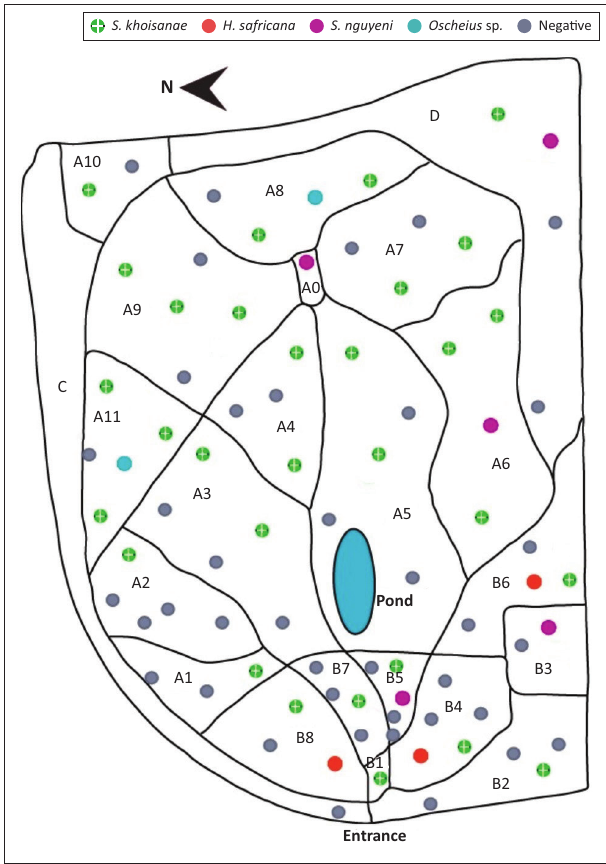
FIGURE 1: Map showing sites where samples were taken, indicating the positive and negative sampling sites and the different species of entomopathogenic nematodes